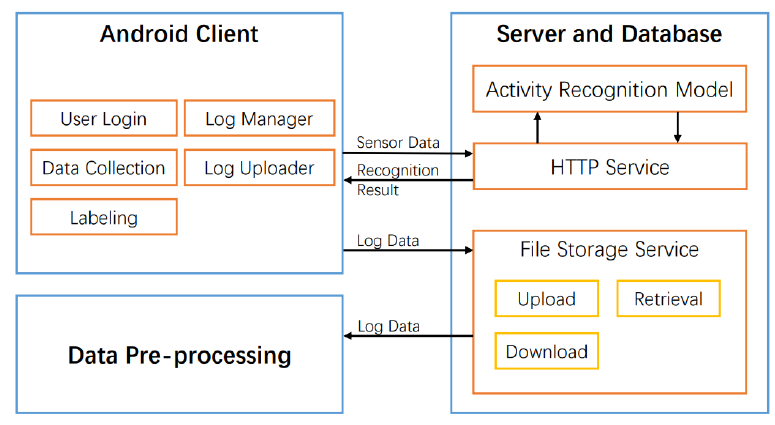
Figure 5. Architecture of MarSense.